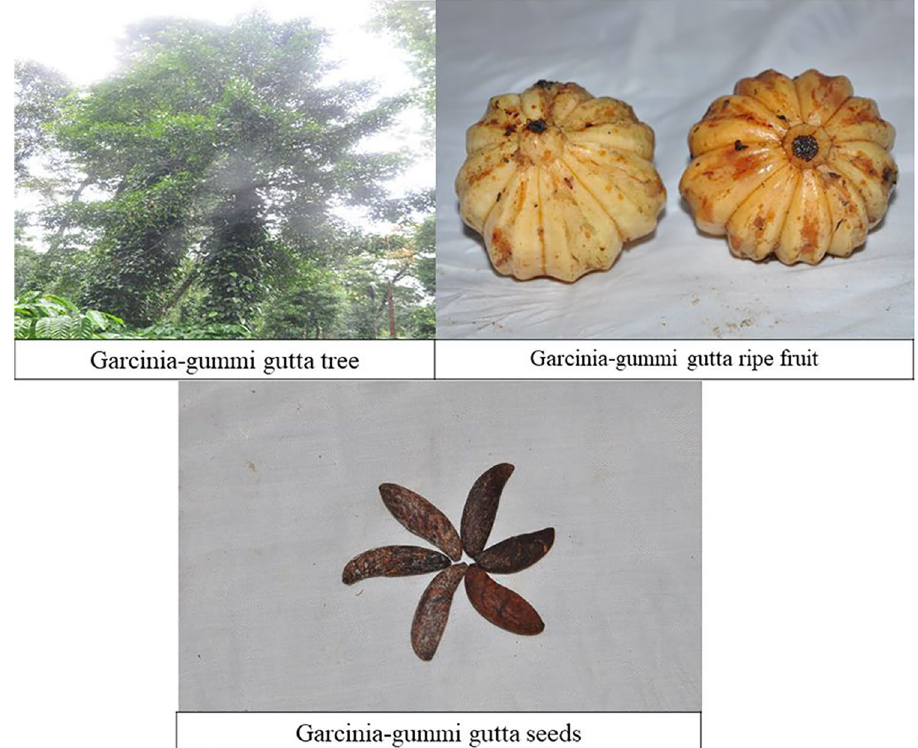
Fig. 1 Garcinia-gummi gutta tree, fruit and seed